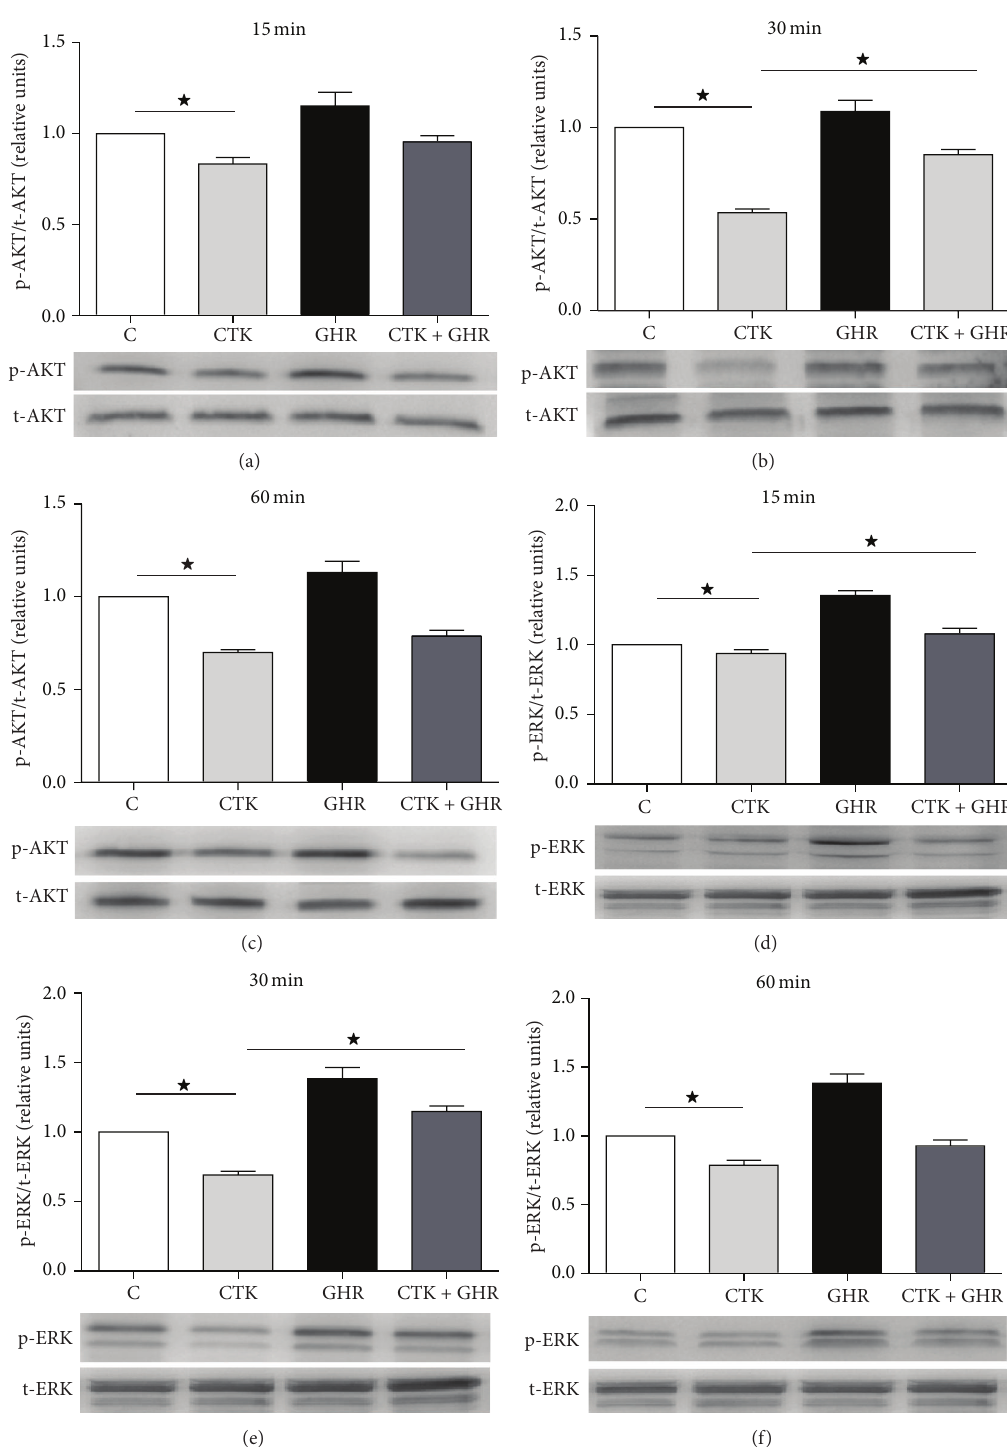
Figure 2: Western blot for phosphorylated AKT (a, c, and e) and ERK 1/2 (b, d, and f). Immunoblotting was performed to quantify phosphorylation level or AKT an ERK 1/2 treated with proinflammatory cytokines during 15 (a and d), 30 (b and e), and 60 min (c and f) alone or in presence of ghrelin. Panels below the graph show representative images of immunoblots. Results are expressed as mean ± SEM of phosphorylated to total protein ratio and referred to control cultures (c). Values were obtained from 4 independent experiments. * 𝑝 < 0.05 between groups. C, control; CTK, cytokines; GHR, ghrelin; CTK + GHR, cytokines +